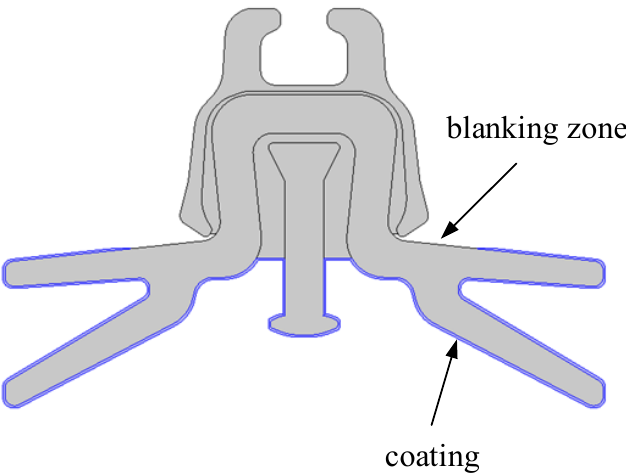
Figure 24. Schematic diagram of “switching effect” electrothermal coating.